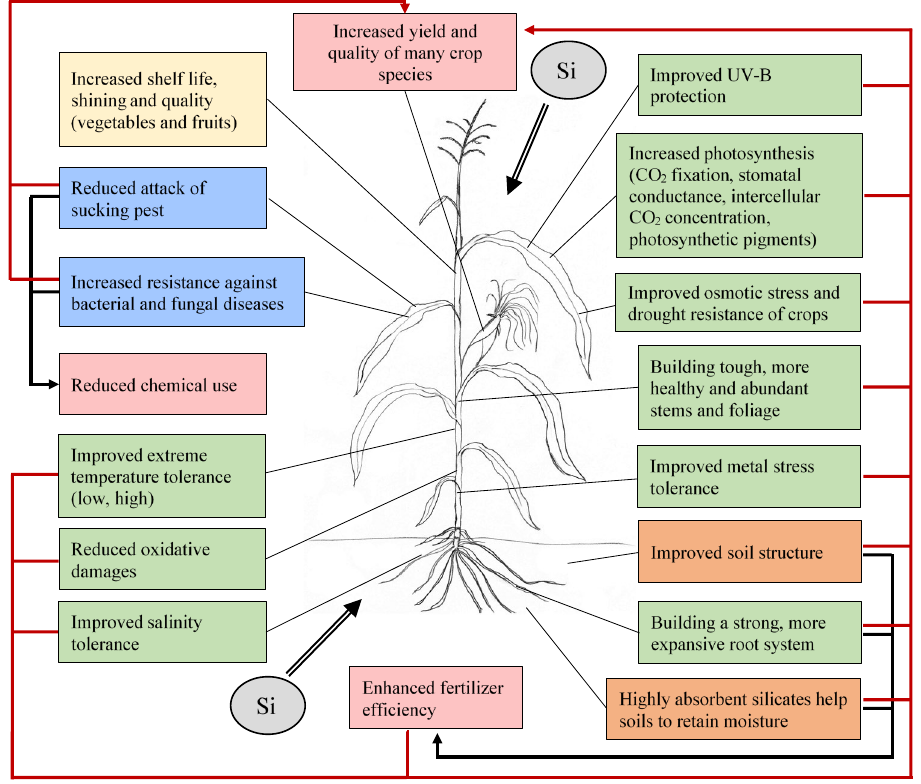
Figure 3. Effects of silicon application in the crop production space.